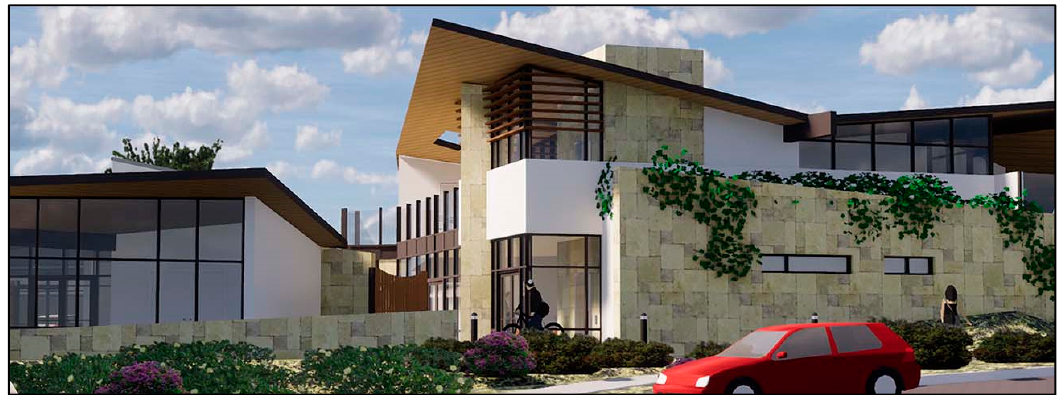
Figure 19. Digital Visualization: Glickman Hillel Center at UCSD, Project Exterior. Image Credits: © M. W. Steele Group, used by permission.